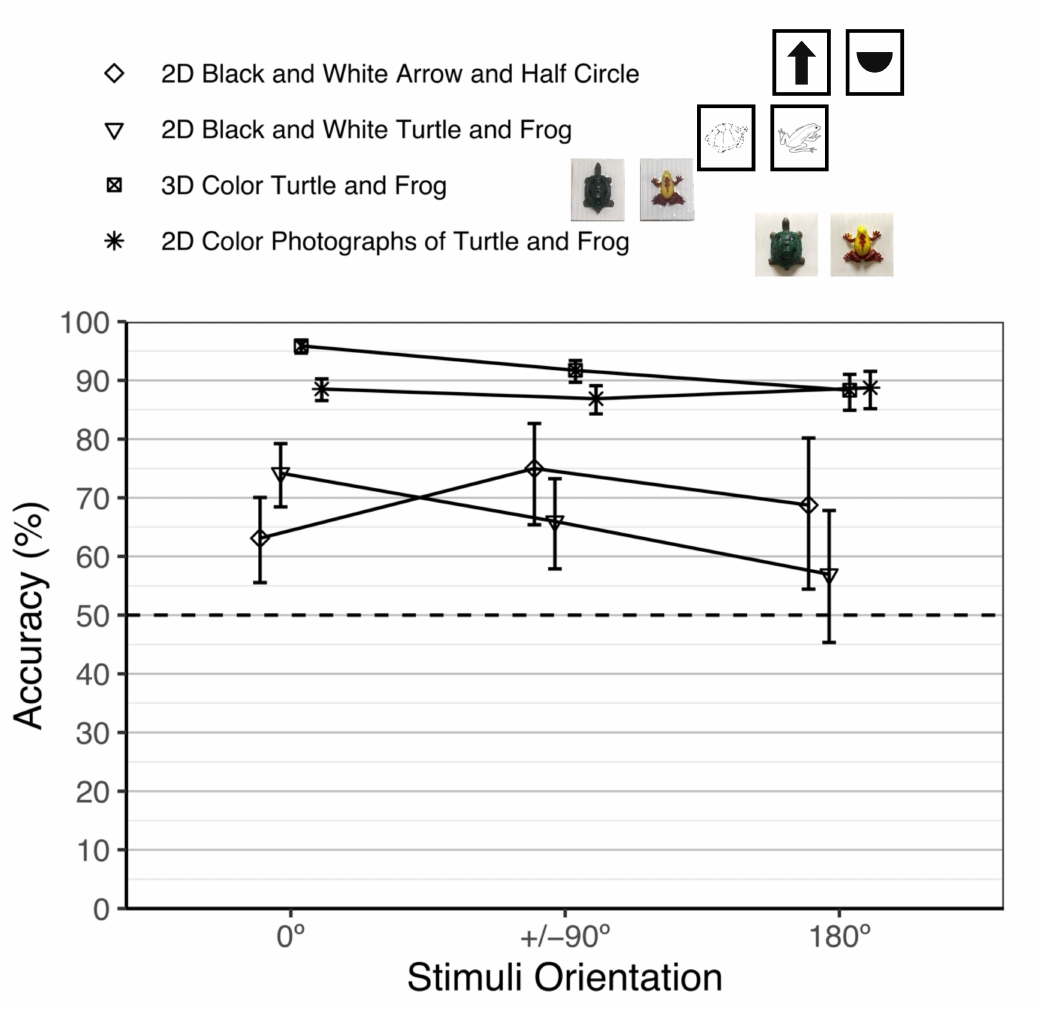
Figure 4. Comparison of performance accuracy on stimuli orientation across our different studies. 95% confidence intervals from the fixed-effects meta-regression model are shown. The 2D black and white stimuli are from DeLong et al. [45], 3D color turtle and frog is from DeLong et al. [15], and 2D color photographs of turtle and frog is from the current study. The fish performed significantly worse at 0 ◦ and +/ − 90 ◦ on the current study compared to the 3D color turtle and frog study (there was no significant difference in performance at 180 ◦ ). The fish performed significantly better on the current study compared to both studies with black and white